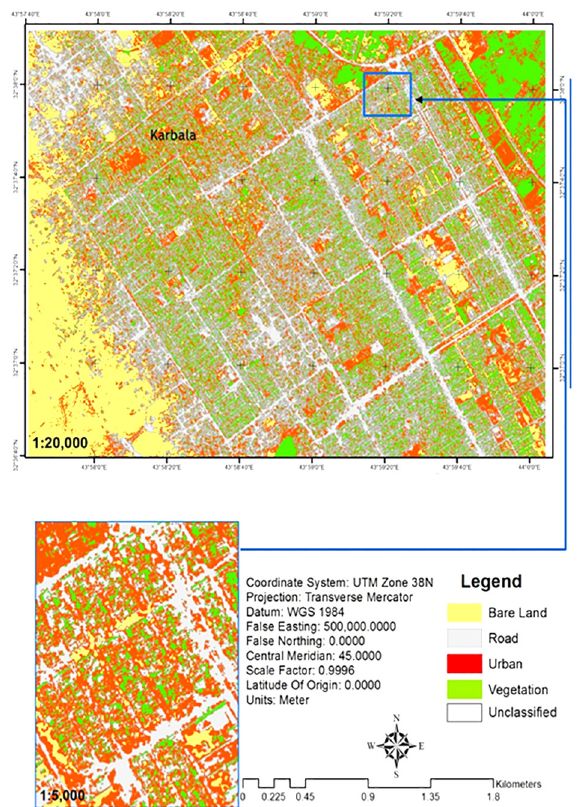
Figure 7. Maximum Likelihood classification map Accuracy assessment is an integral part of any image classification because it used different classification meth- ods may classify pixels or group of pixels to wrong classes. Error matrix is a standard method to represent classifica- tion accuracy.